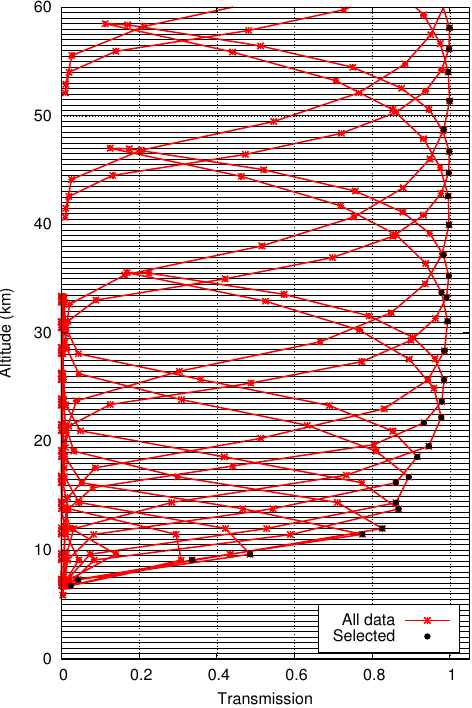
Figure 2. Illustration of selection of data. The transmission at about 1560nm, i.e. outside the strong absorption, is shown as a function of altitude. Red points show all readouts, connected by lines to il- lustrate the temporal sequence. Black points show readouts used in the retrieval. The basic idea for the selection is to take the mea- surements with the highest transmission within one vertical bin of 0.5km (indicated by horizontal black